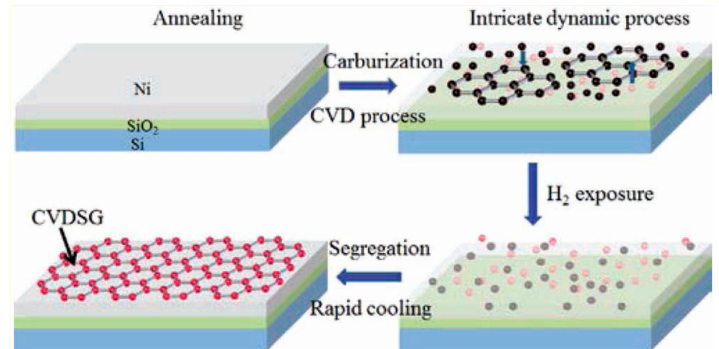
Figure 4. Chemical vapor deposition for graphene production. Reproduced with permission from [64].